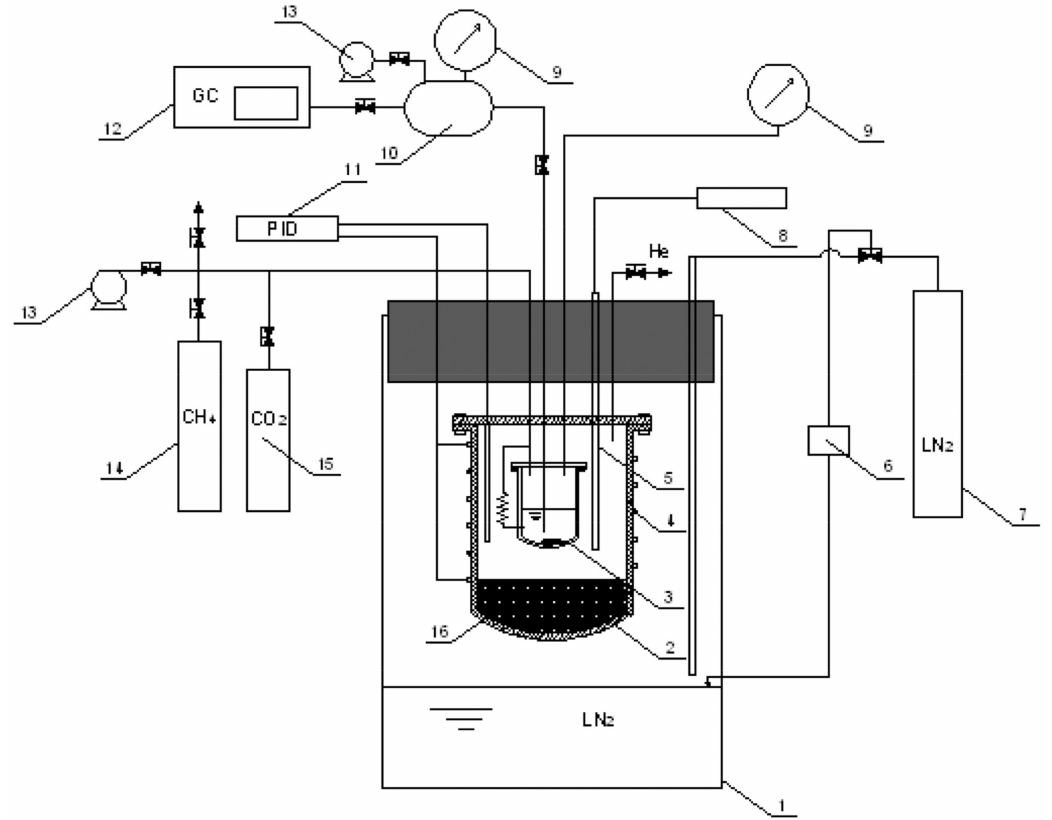
Figure 1. Cryogenic solid–liquid equilibrium apparatus built by Shen et al. [9]: 1, cryostat; 2, ther- mostat; 3, equilibrium cell; 4, heating wire; 5, platinum resistance thermometer; 6, level controller; 7, liquid nitrogen vessel; 8, digital indicator; 9, pressure transducer; 10, buffer tank; 11, PID tempera- ture regulator; 12, gas chromatograph; 13, vacuum pump; 14, solvent reserve; 15, solute reserve; and 16, insulation